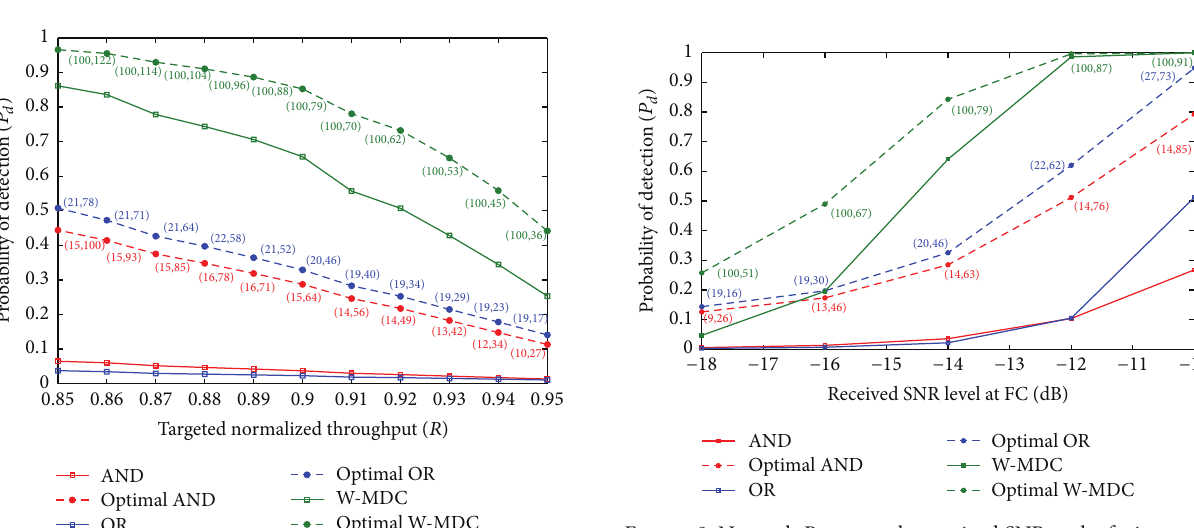
Figure 8: Network 𝑃 𝑑 versus the received SNR at the fusion center (in dB) for AND, OR, and weighted MDC fusion scheme; network with 100 SUs, targeted normalized throughput = 0.9, and maximum sensing time of 𝜏 max = 100 𝜇 s with ( 𝑘 opt , 𝜏 opt ) are shown in the data